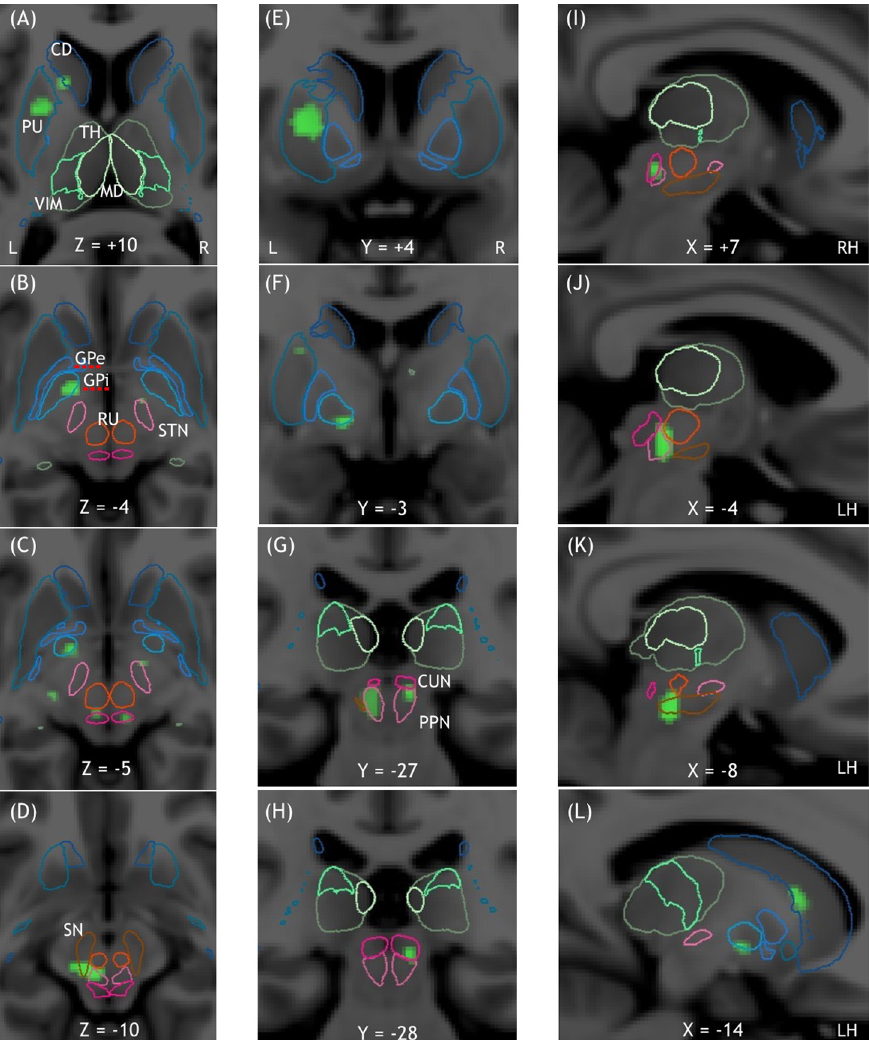
Fig 4. Midbrain clusters of the GAIT DOORWAY-WALKWAY DOORWAY contrast represented overlaid on the MNI152 template. The contours of the nuclei of the thalamus, the basal ganglia, and MLR are given by the YeB atlas mapped to the MNI template. Midbrain and MLR clusters are shown in horizontal (A, B, C, D), frontal (E, F, G, H), and sagittal (I, J, K, L) sections. GAIT DOORWAY—WALKWAY DOORWAY showed clusters in the left caudate nucleus (A, L), left putamen (A, E, F), left internal globus pallidus (B, C, F, L), right subthalamic nucleus (B, C), bilateral CN and PPN (D, G, I, J, H), and left substantia nigra (D,